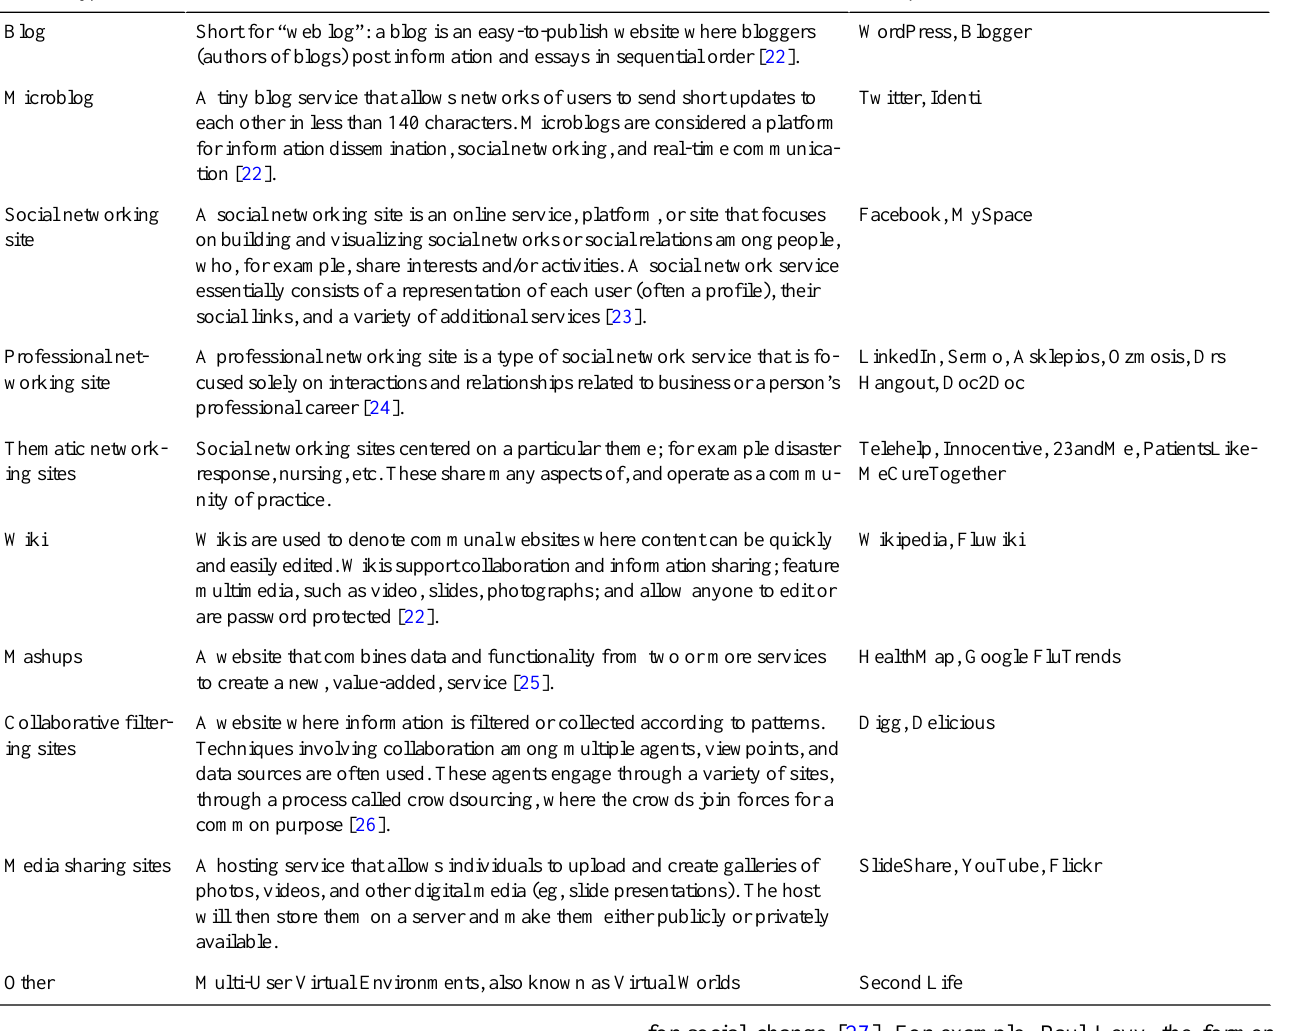
Table 1. Categorical definitions of social media. ExampleDefinitionService